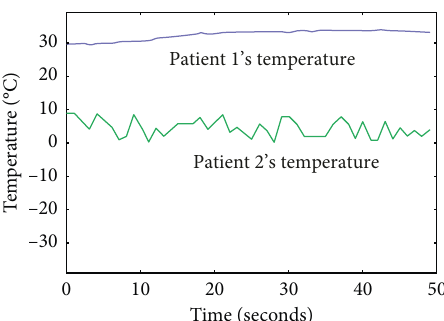
Figure 5: Patient data received on the server side.